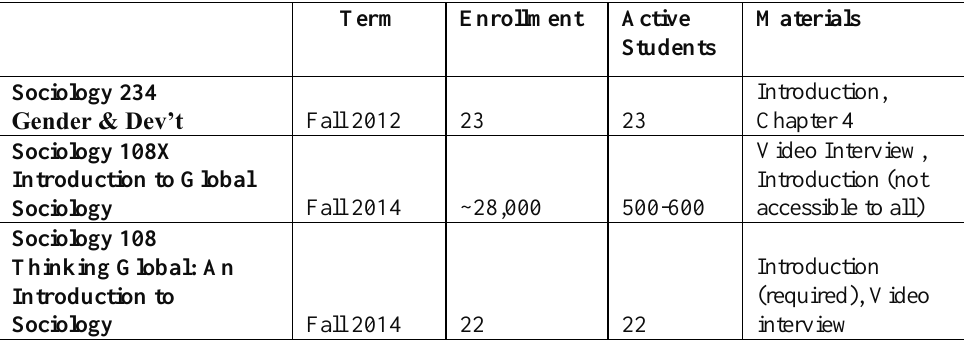
Table 1: Course Contexts in which WAITDT Was